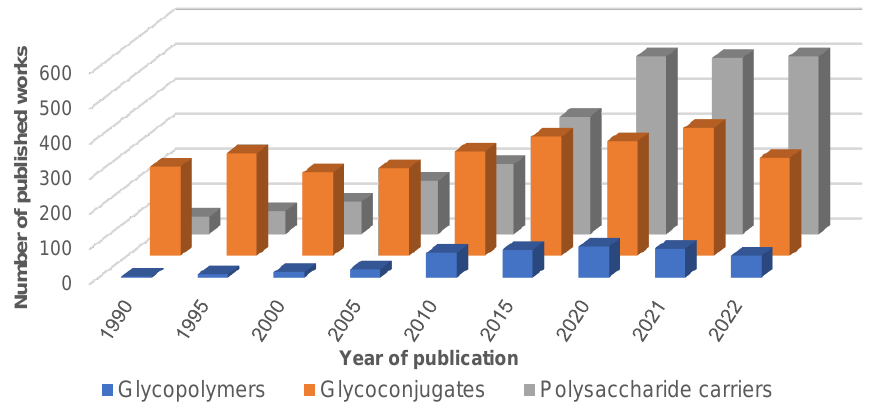
Figure 15. Publications per year on selected sugar applications, based on a Scopus search using the keywords ‘glycopolymers’, ‘glycoconjugates’, and ‘polysaccharide carriers’ (access date: 15 January 2023).